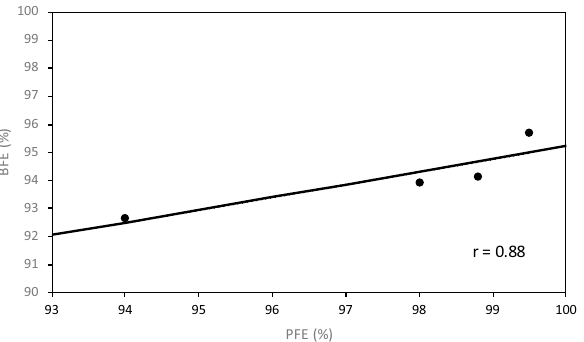
Figure 4. Correlation between PFE values obtained using the AFNOR SPEC S76-001 test protocol and BFE values obtained using the EN 14683 test